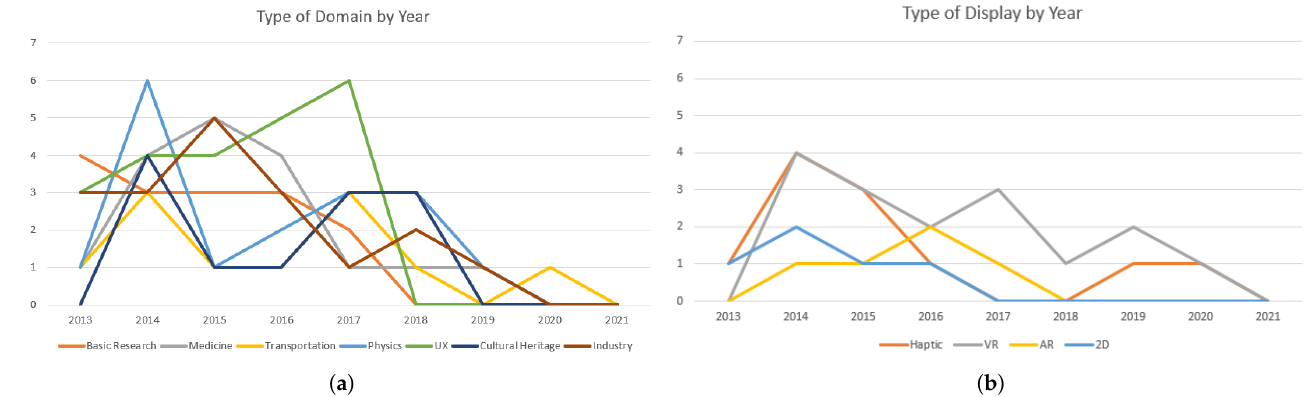
Figure 2. Temporal analysis charts. ( a ) Number of papers of domain per year. ( b ) Number of papers of different technologies per year.